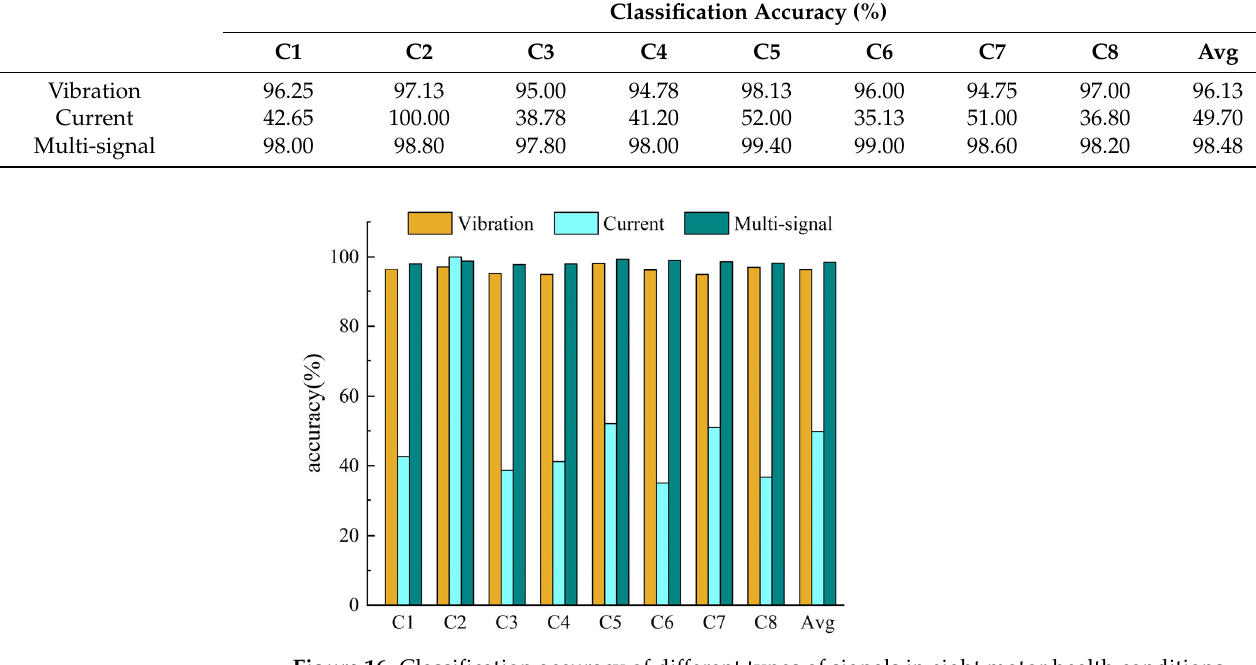
Figure 16. Classification accuracy of different types of signals in eight motor health conditions. Table 3. DCNN classification accuracy based on single signals and the